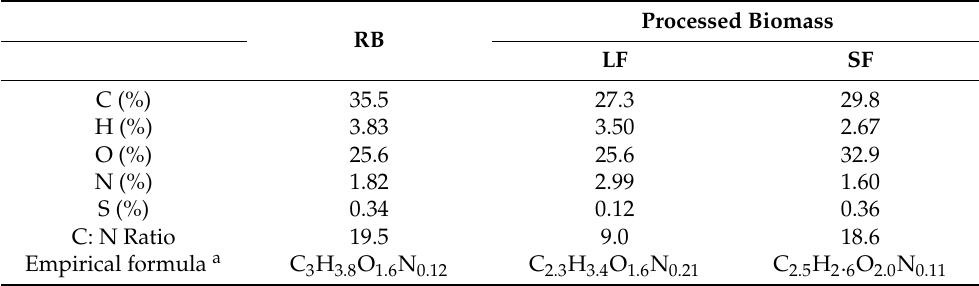
Table 2. The organic elemental analysis of raw (RB) and processed Sargassum spp. biomass from the Mexican Caribbean: liquid (LF) and solid fractions (SF) on a dry basis ( n = 1). Processed Biomass RB LF SF C (%) 35.5 27.3 29.8